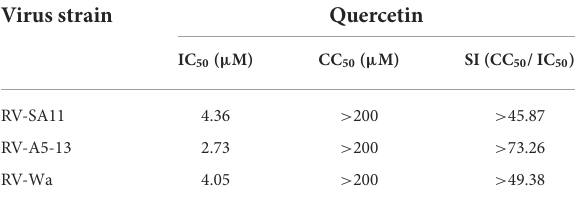
TABLE 1 IC 50 , CC 50 , and SI of quercetin against three RV strains. Virus